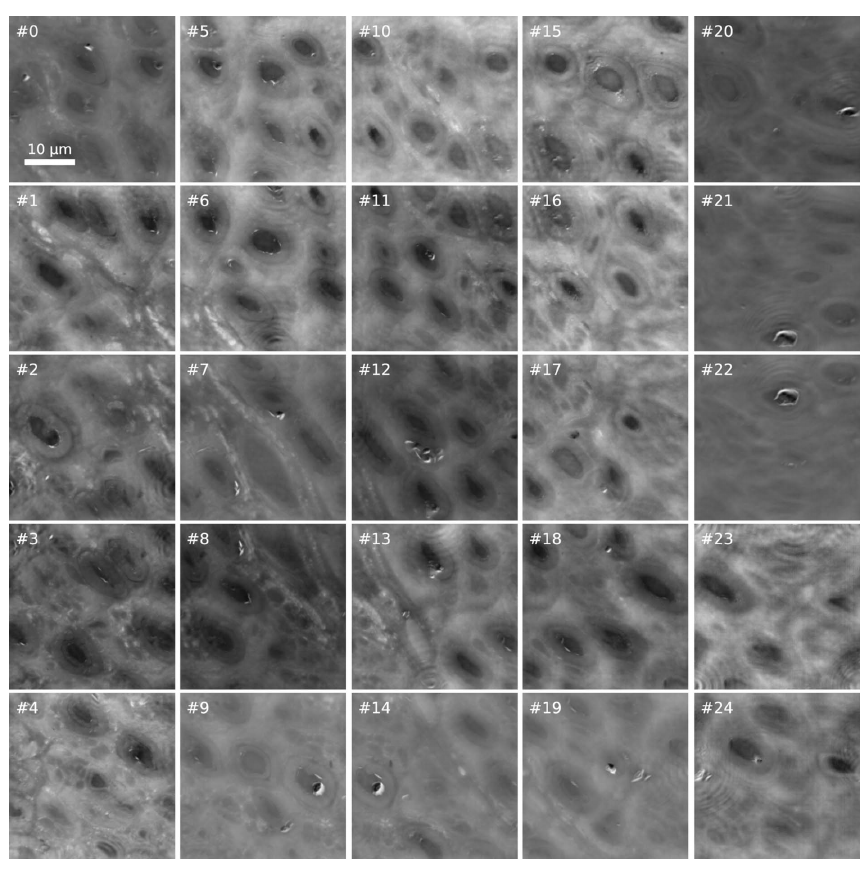
Figure 2 Preliminary reconstructions from a 5 (cid:3) 5 holography scan covering a potential ROI of a section of an Os-stained human peripheral sural nerve biopsy from a healthy male. These qualitative results were used to delimit a ROI on which to perform a nanoscale X-ray fluorescence scan, as more conveniently annotated in Fig. 3. Further processing followed. The frame number is annotated on each frame, revealing the scanning sequence.